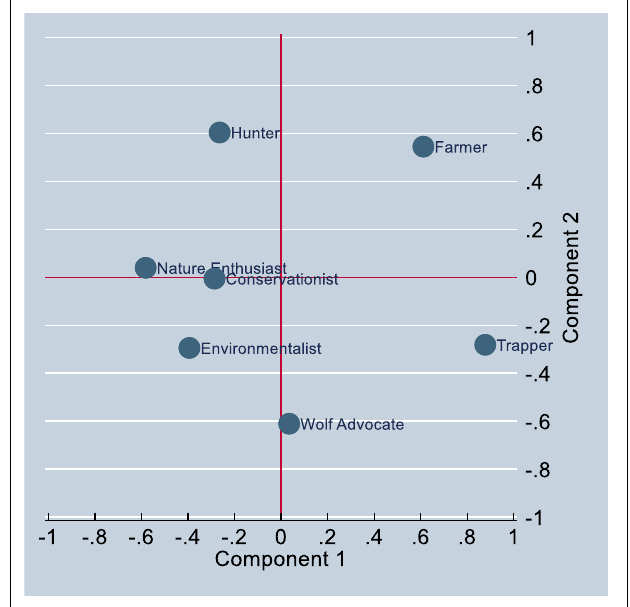
FIGURE 1 | Multidimensional scaling of putative identities of wolf stakeholders in Minnesota, United States.